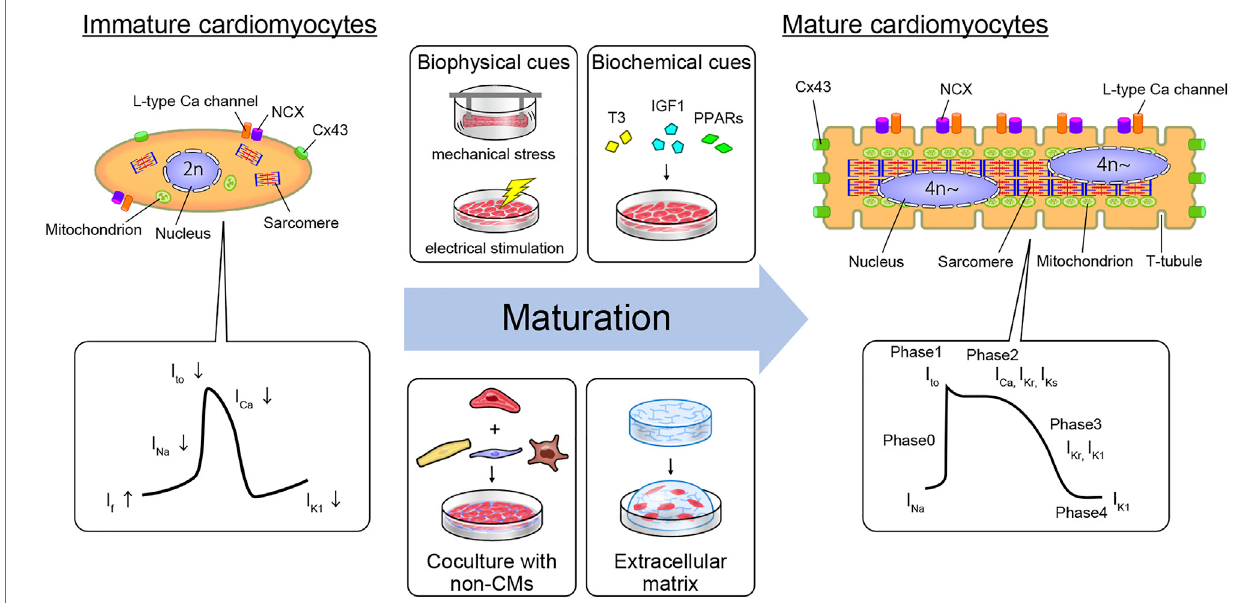
FIGURE 1 | Cardiomyocyte maturation features and strategy to generate mature hiPSC-CMs in vitro . The structural and electrophysiological features of hPSC- derived CMs resemble those of fetal human CMs but not those of adult human CMs. Mature humans and immature CMs contain different features in their constituents. Moreover, APs differ due to differences in the expression levels of some ion channels. Immature hPSC-derived CMs can be driven toward a more mature adult CM phenotype using biophysical cues (e.g., mechanical stress or electrical stimulation), biochemical cues (the addition of T3, IGF1, or PPARs to the culture medium), coculture with non-myocyte cell types such as CF, EC, and macrophages, or by growing in the extracellular matrix. Abbreviations: CM, cardiomyocyte; CF, cardiac fi broblast; Cx43, connexin 43; EC, endothelial cell; IGF1, insulin-like growth factor 1; ICa, calcium channel current; If, pacemaker or funny current; IK1, inward-recti fi er potassium current; IKr, rapid delayed-recti fi er potassium current; IKs, slow delayed-recti fi er potassium current; INa, sodium current; Ito, transient outward potassium current; NCX, sodium-calcium exchanger; PPARs, peroxisome proliferator-activated receptors; T3, triiodothyronine.